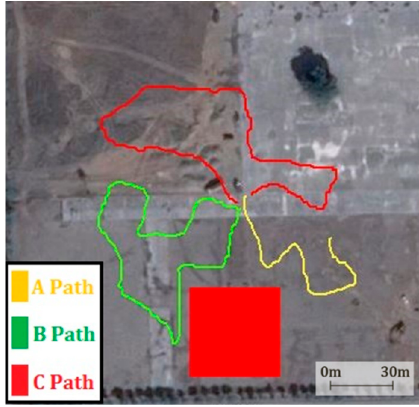
Figure 22. Experiment trajectory when the task was accomplished.